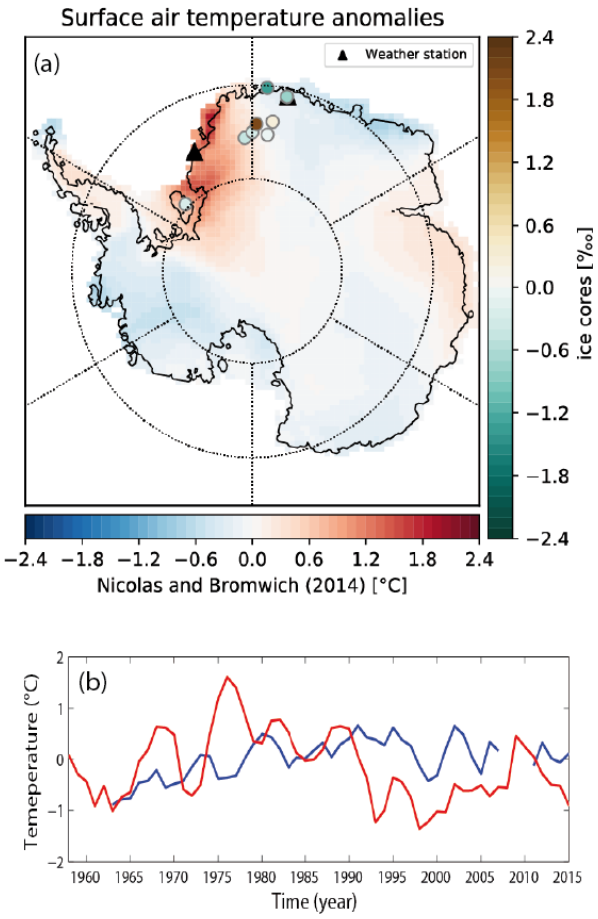
Figure 2. (a) Annual mean temperature anomaly ( ◦ C) averaged over 1974–1976 compared with the 1958–2000 period in the Nico- las and Bromwich (2014) reconstruction. The dots correspond to the δ 18 O (‰) anomalies for the same period in ice cores in the region of interest. (b) Annual mean temperature anomaly ( ◦ C) at Halley (red) and Novolazarevskaya (blue) weather stations (highlighted in panel a ). A 3-year running mean has been applied to the series.